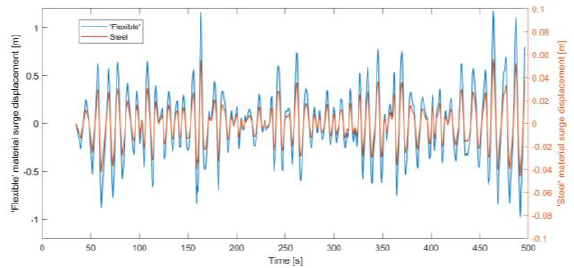
Fig. 9. Time series of displacement in surge at the top of the flap for different material stiffnesses – static analysis – steel (in red, left axis) and flexible (in blue, right axis) materials